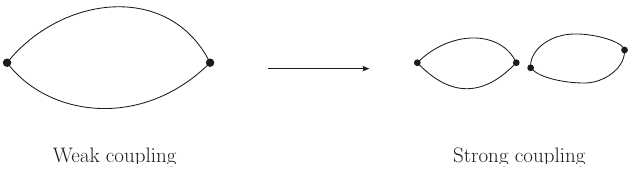
Figure 14. From the (cid:13)ux tube picture, at strong coupling, the energy is large enough to generate pairs of charged particles, so that a single trace operator at weak coupling splits into multiple smaller single